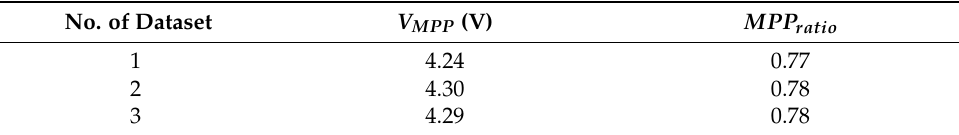
Table 2. The MPP measurement results for 3